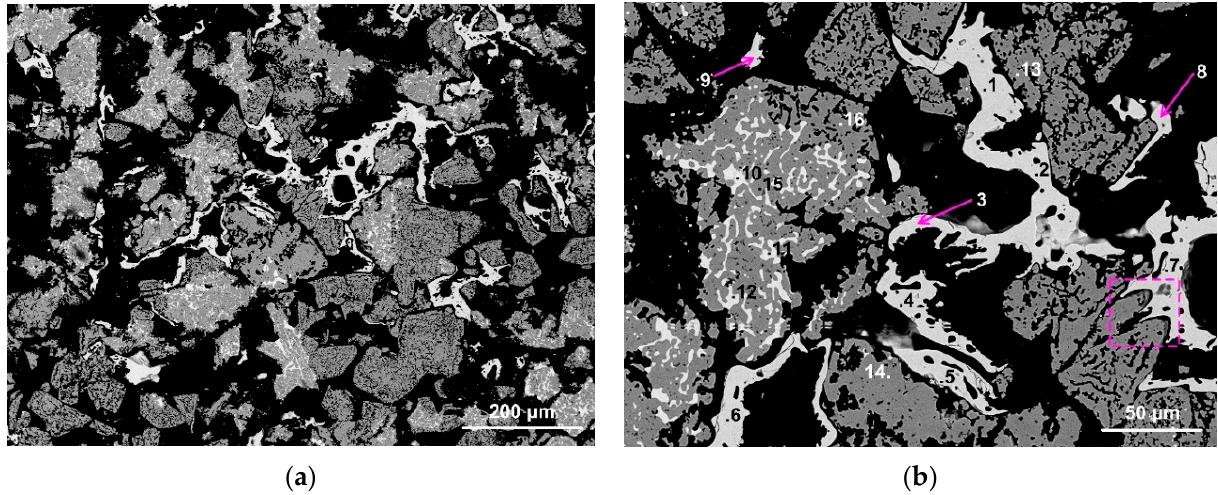
Figure 5. ( a ): Sample B BSE image: 1200 ◦ C, 5% Fe addition; ( b ): Magnified sample B analysis area BSE image: 1200 ◦ C, 5% Fe addition; (grey = MnO, white = alloy). Table 2. SEM-WDS analyses of points in Figure 5b.